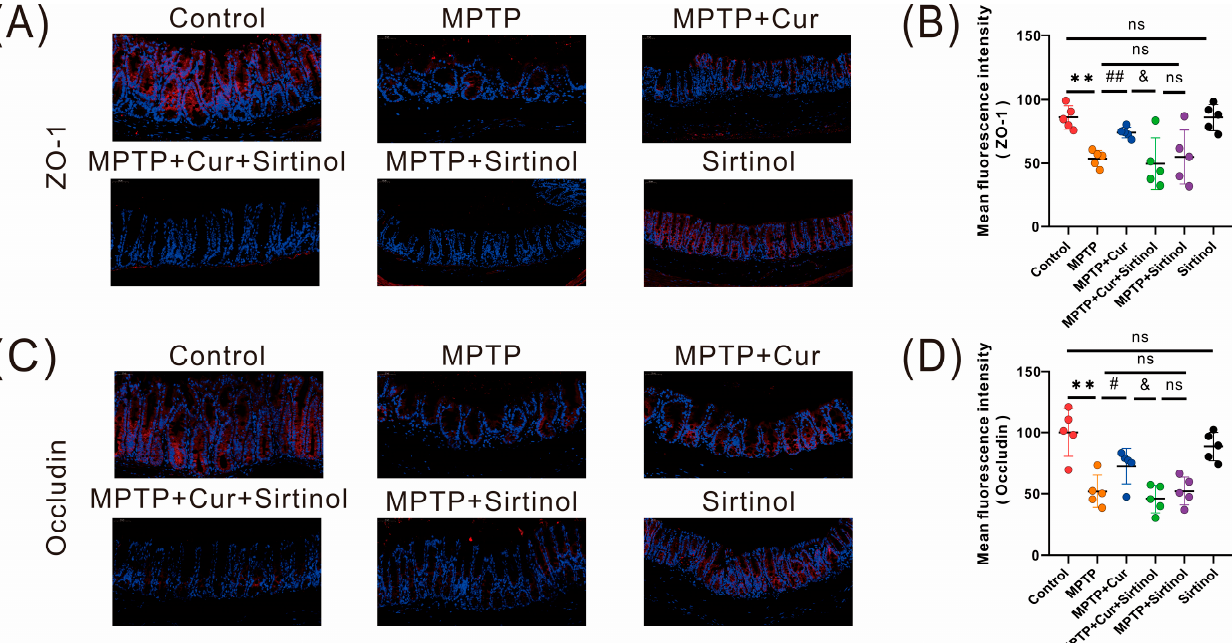
Figure 8. Curcumin ameliorated gastrointestinal barrier disruption by reducing intestinal inflam- mation in MPTP-induced mice. (A,C) representative immunofluorescence images of ZO-1- and oc- cludin-positive cells in the cecum (n = 5); (B,D) analysis of ZO-1 and occludin fluorescence intensity in the cecum. The quantitative analysis of ZO-1- and occludin-positive regions was performed using ImageJ. All statistical differences were tested using the t -test using (B,D). Data are expressed as the mean ± SEM (n = 5/group). Representative results are for one of the independent experiments.** p <